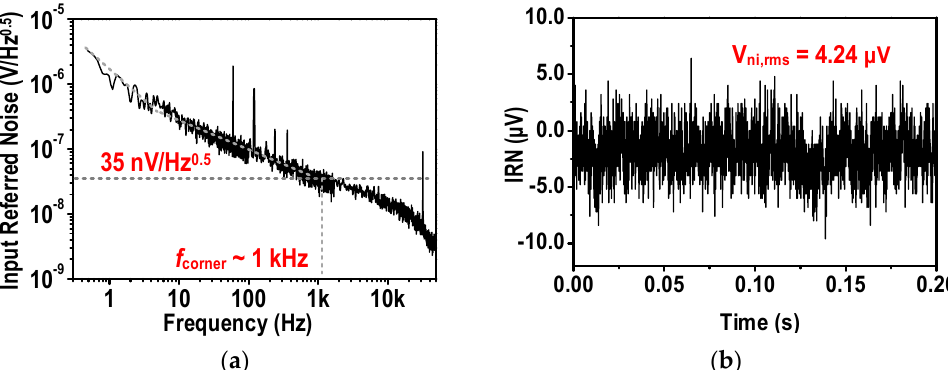
Figure 13. LNA noise characterization: ( a ) Input referred noise voltage spectrum from 0.4 Hz to 50 kHz; ( b ) Input referred transient noise voltage waveform.